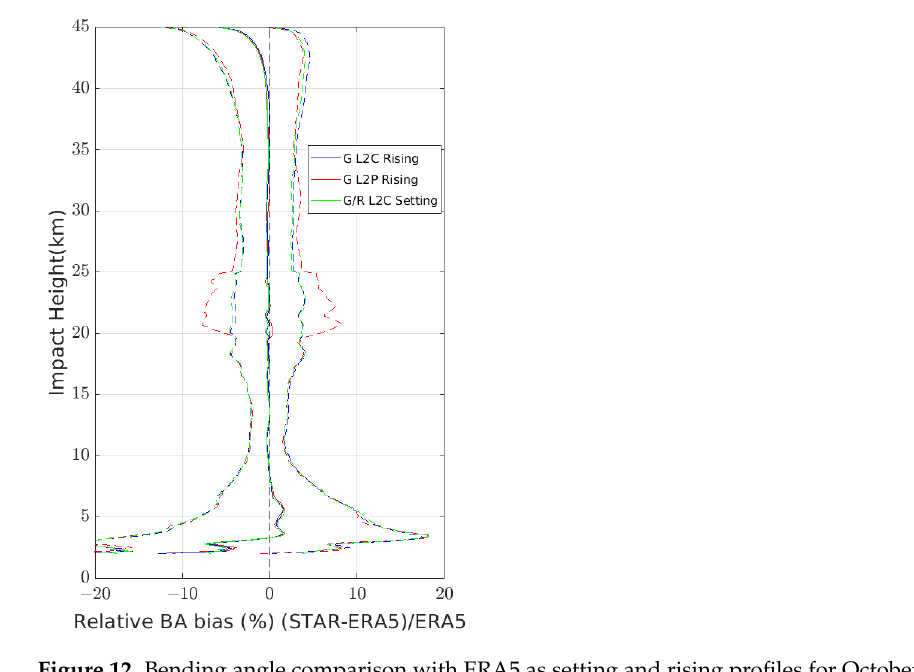
Figure 12. Bending angle comparison with ERA5 as setting and rising profiles for October 2019. The middle lines are mean relative differences, with standard deviation as outer lines. Red is for L2P rising, blue is for L2P setting, and green is for L2C (GPS and GLONASS). Profiles exceeding 10 sigmas at a height between 10 and 45 km have been removed in the comparison.